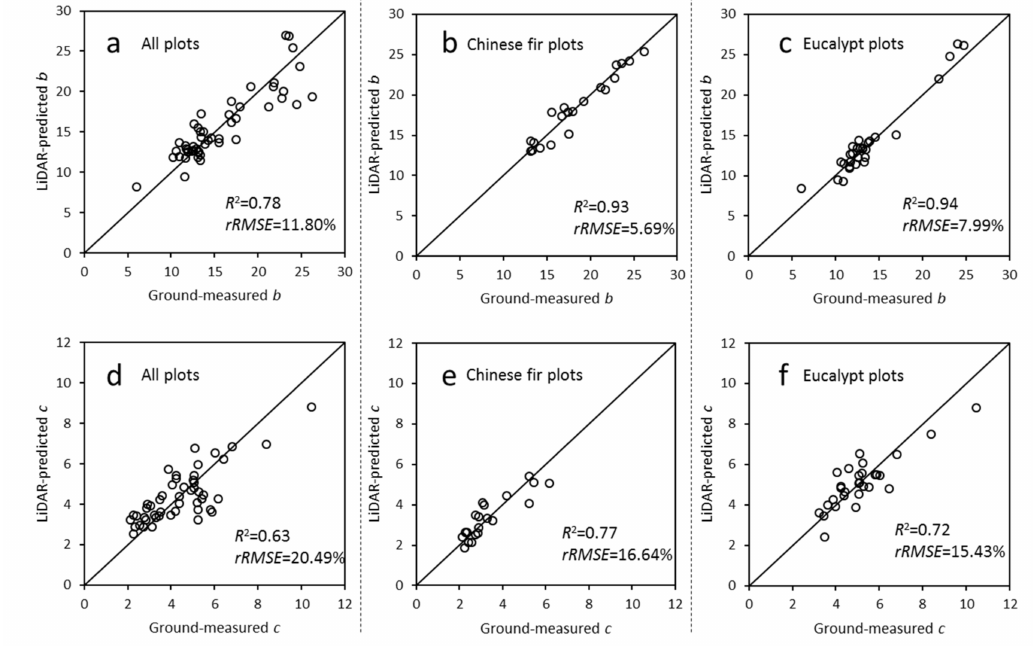
Figure 3. Scatter plot of cross-validations for the ground-measured unimodal Weibull model (UWM) parameters vs. the LiDAR-predicted UWM parameters in undifferentiated plots. ( a , e ) all plots; ( b , f ) Chinese fir plots; ( c , g ) Eucalypt plots.